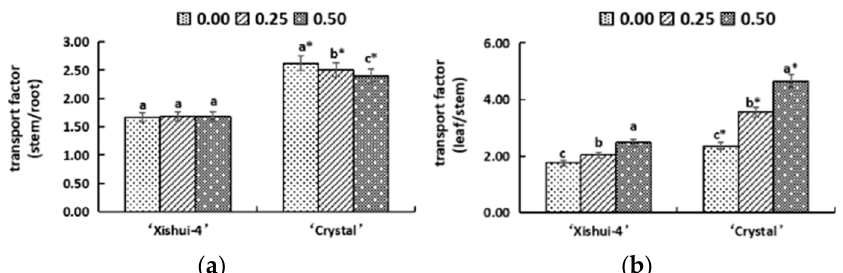
Figure 6. Effects of B-deficiency on transport factor of two grape genotypes: ( a ) TF root → stem ; ( b ) TF steam → leaf. Different lowercase letters within each column are significantly different at p < 0.05 between treatments. * is significantly different at p < 0.05 between genotypes.